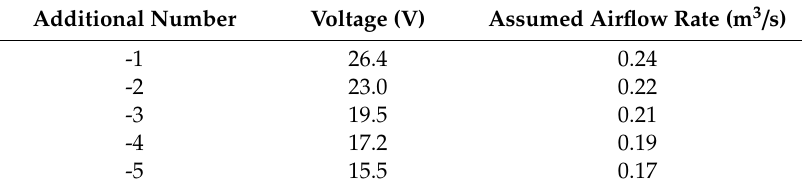
Table 7. Voltage setting and assumed airflow rate of heat generator.